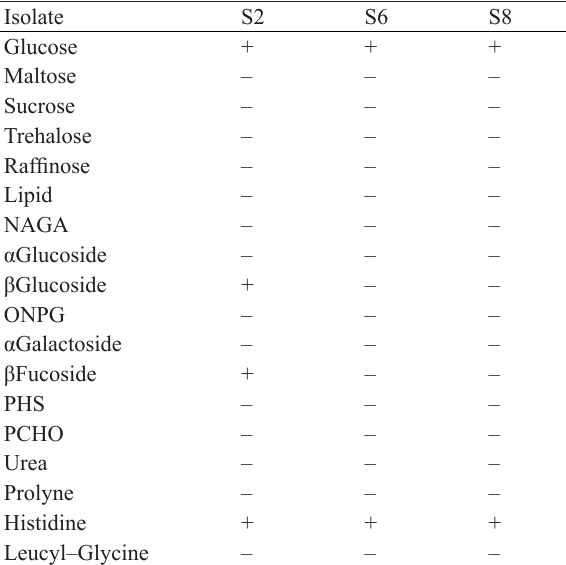
Table 3 Identification of indigenous yeast from napa cabbage waste